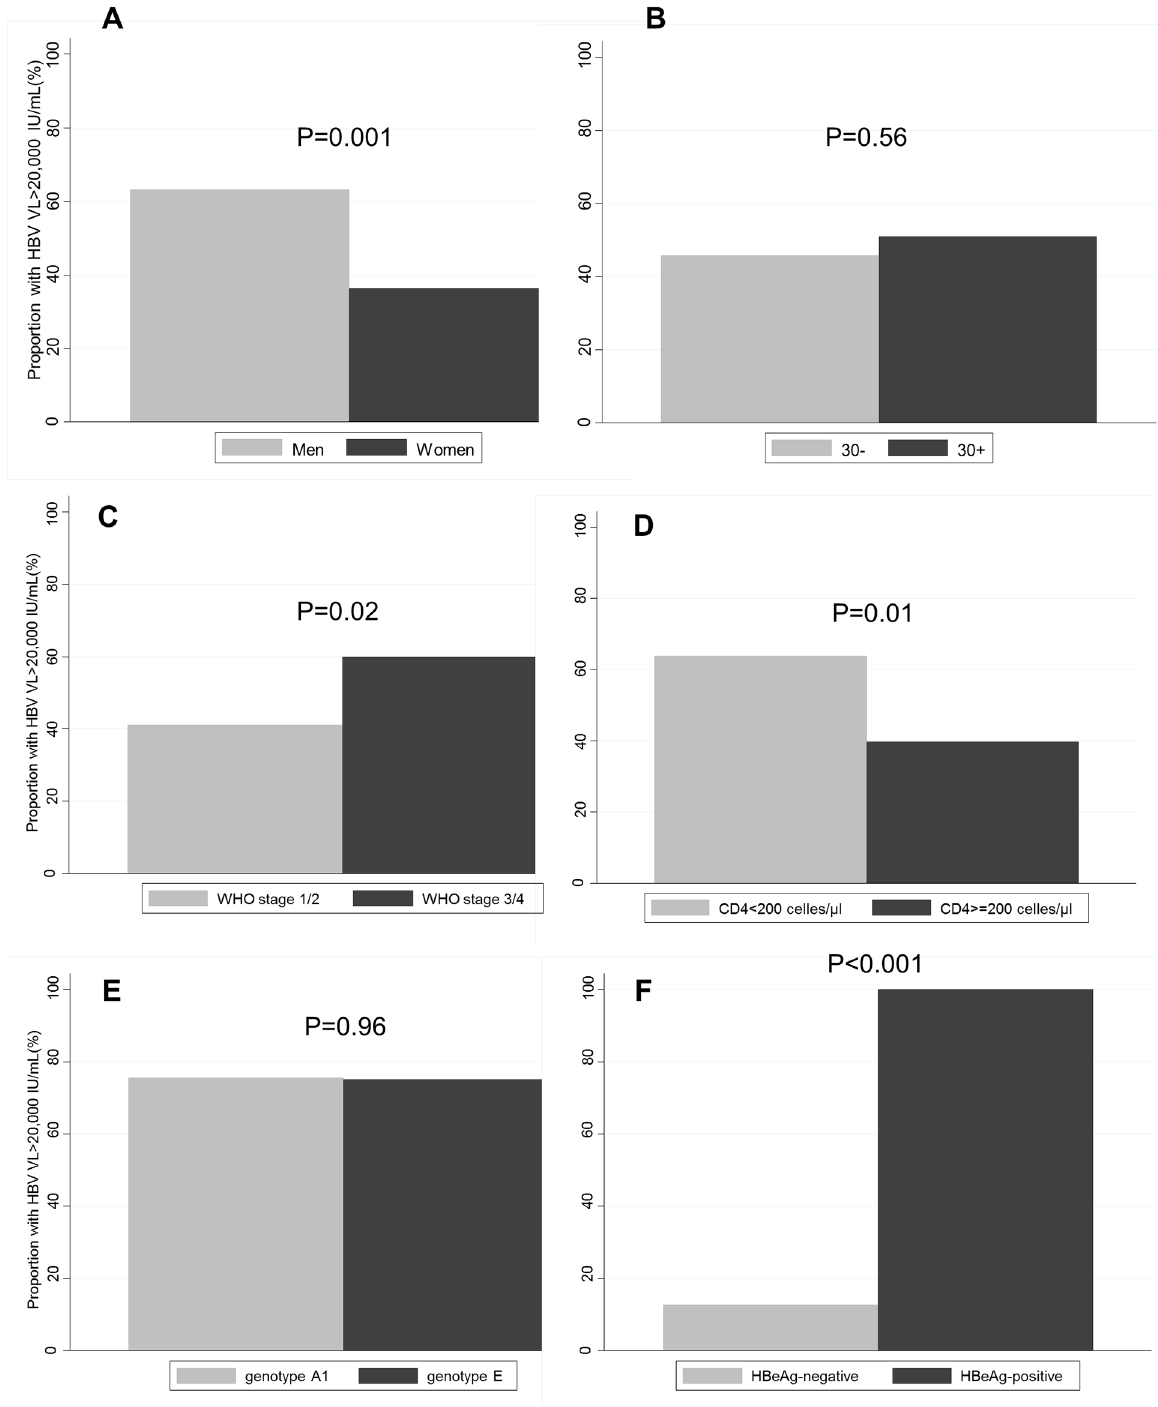
Fig 2. Proportion of patients with high HBV viral load ( > 20,000 IU/mL), by sex (Panel A), age (B), WHO stage (C), CD4 cell count (D), HBV genotype (E) and HBeAg-positivity (F).